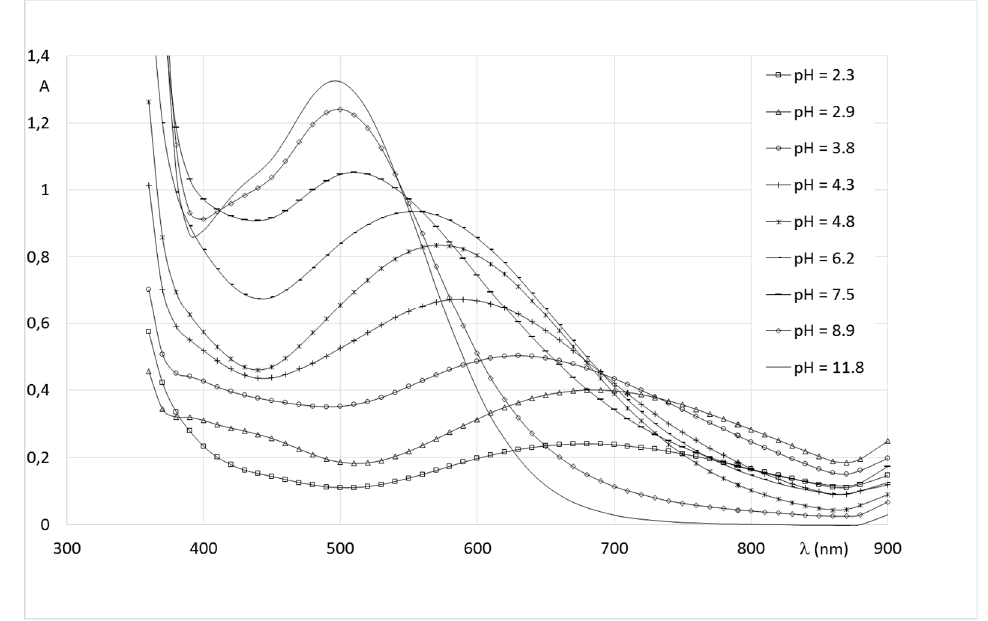
Figure 6. Spectrophotometric titration of Fe(III)- 1 solutions.